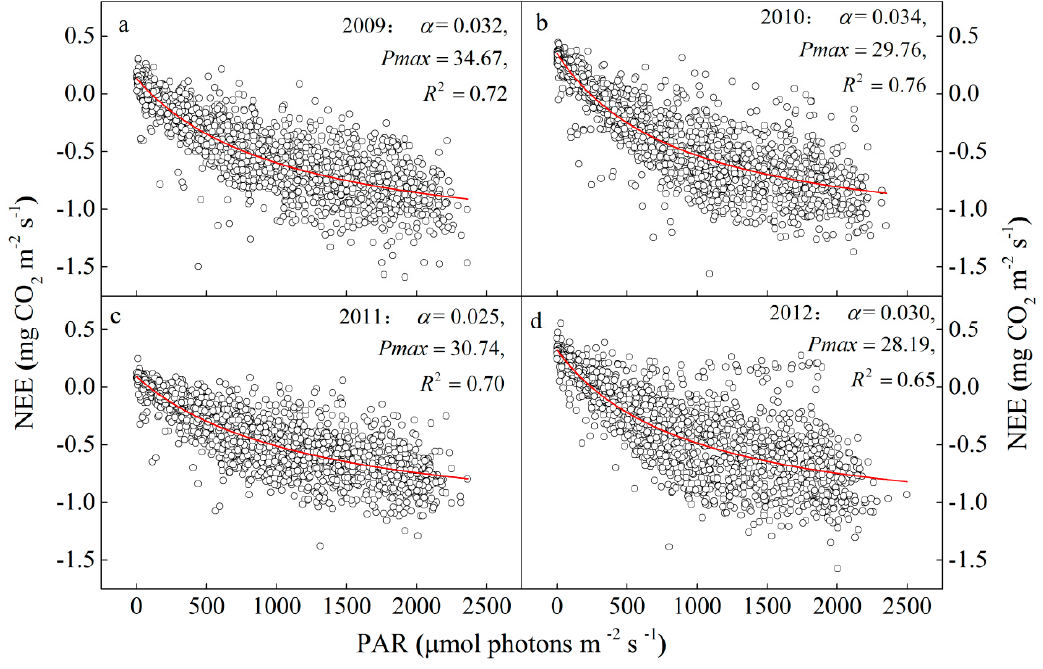
Figure 2. The maximum light use efficiency estimation using the light response curve derived from the Michaelis-Menten equation based on daytime EC measurement data from 2009 to 2012 ( a – d ). The Pmax ( μ mol CO 2 m − 2 s − 1 ) is the maximum ecosystem photosynthesis rate. α ( μ mol CO 2 μ mol photons − 1 ) is the maximum light use efficiency.